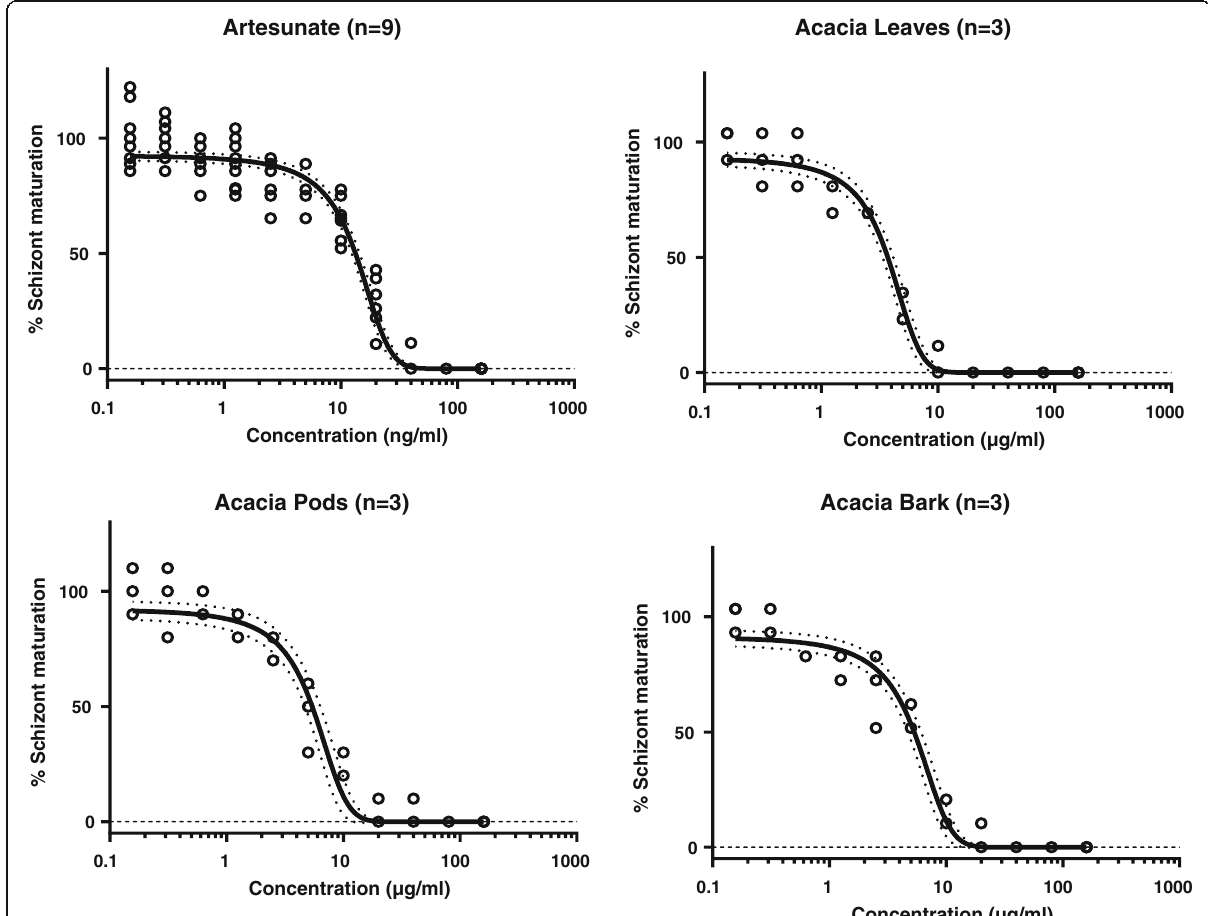
Fig. 5 Maturation of P. falciparum (3D7) after 96 h incubation with A. nilotica extracts. Open circles represent observations, the solid lines represent the estimated mean curves, and the broken lines represent the 95% confidence intervals of the mean estimates